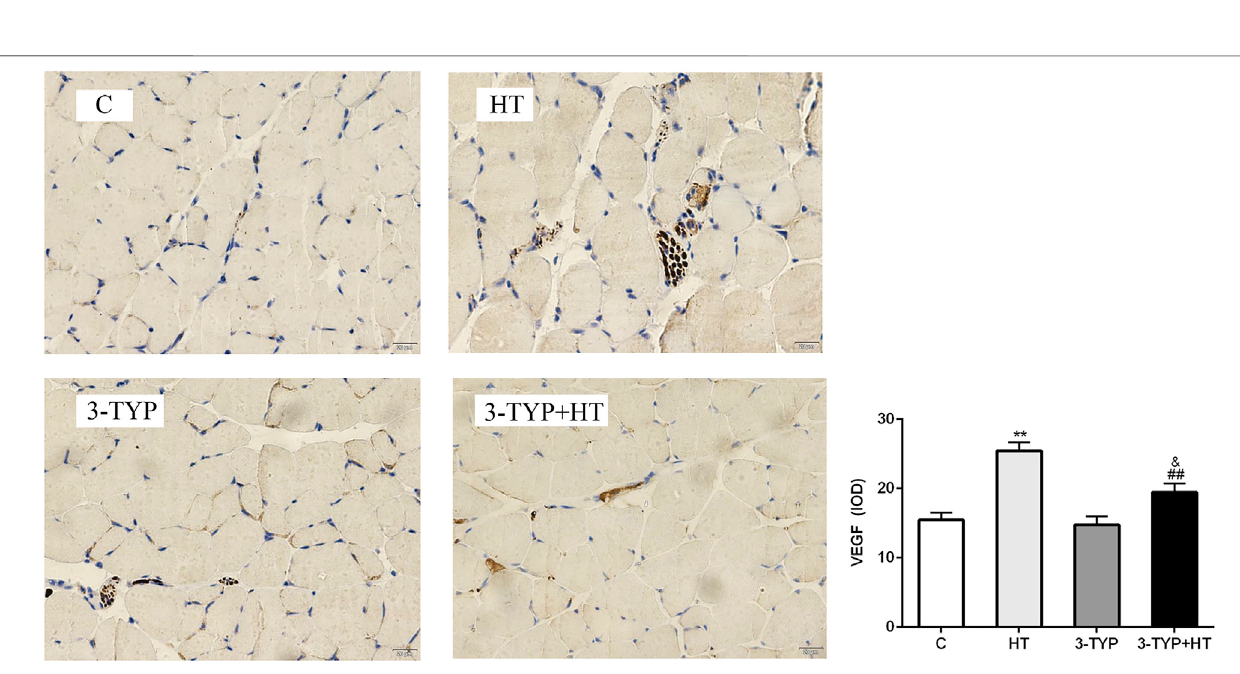
FIGURE 5 | Changes in VEGF levels after Sirt3 inhibition and hypoxic training interventions. (× 400). Scale bars indicate 20 μ m. C, control; HT, hypoxic training; 3- TYP, Sirt3 inhibitor 3-TYP; 3-TYP + HT, 3-TYP + hypoxic training. ** p < 0.01 vs. C; ## p < 0.01 vs. HT; and p < 0.05 vs. 3-TYP. The results were presented as mean ±